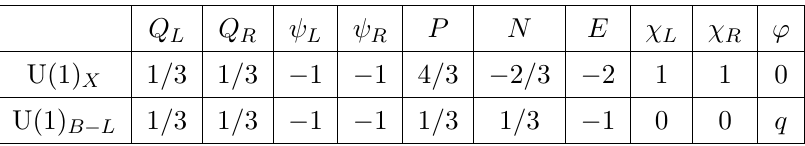
would violate ( B − L ) . Note that under the ( B − L ) symmetry, lepton fields have charge − 1 , while the Higgs doublets have charge zero. The vector-like quarks have ( B − L ) charge of 1 / 3 , while vector-like leptons have charge − 1 . The full list of ( B − L ) charges, along with the U(1) charges of fermions and scalars are listed in table 3. Note that with this X charge assignment the Yukawa structure of eq. (2.10) remains intact even with the gauging of ( B − L )